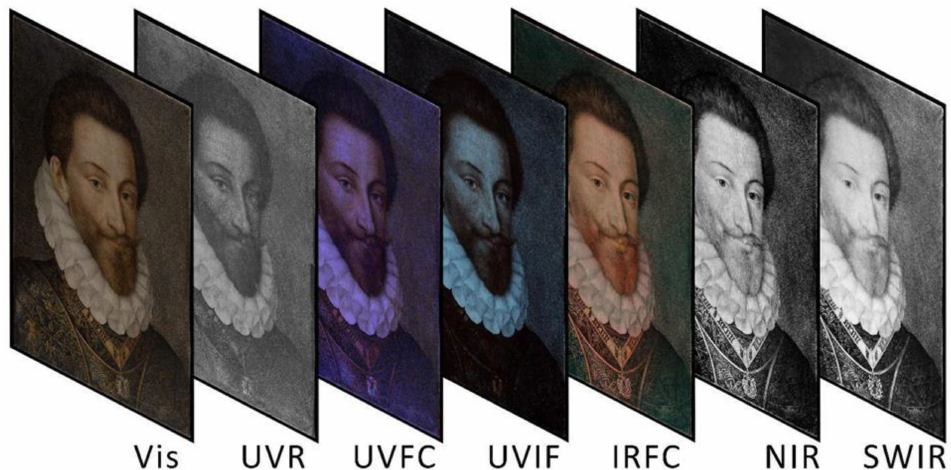
Figure 2. Portrait of Carlo Emanuele I, sequence of multiband imaging in the visible (Vis), reflected ultraviolet (UVR), ultraviolet false color (UVFC), UV-induced visible fluorescence (UVIF), false color infrared (IRFC), infrared between 850 and 1000 nm (NIR), and infrared between 1000 and 1700 nm